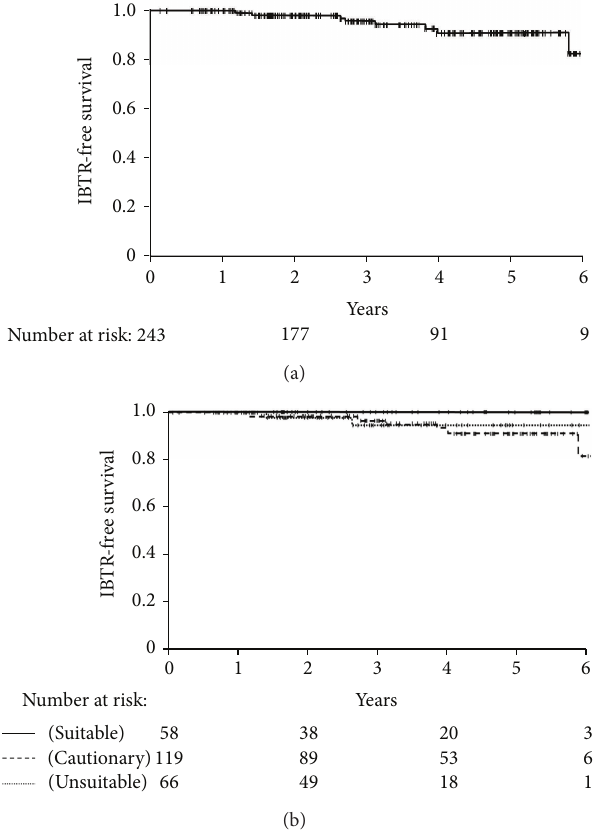
Figure1:(a)Ipsilateralbreasttumorrecurrence-freesurvivalfor243 breast cancers. (b) Ipsilateral breast tumor recurrence-free survival stratified by ASTRO consensus statement grouping.